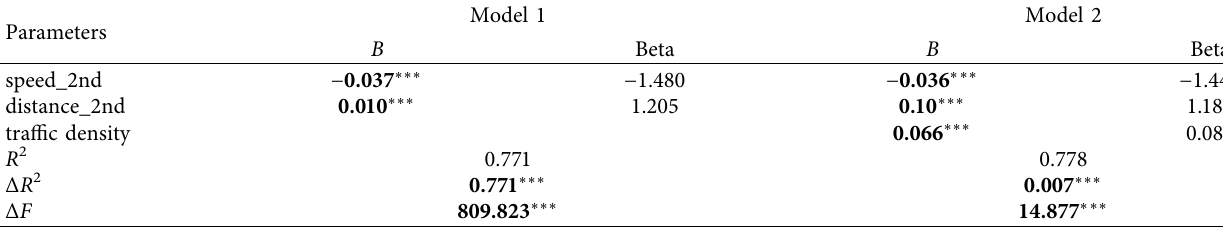
Table 11: Results of the average deceleration based on free-driving state.